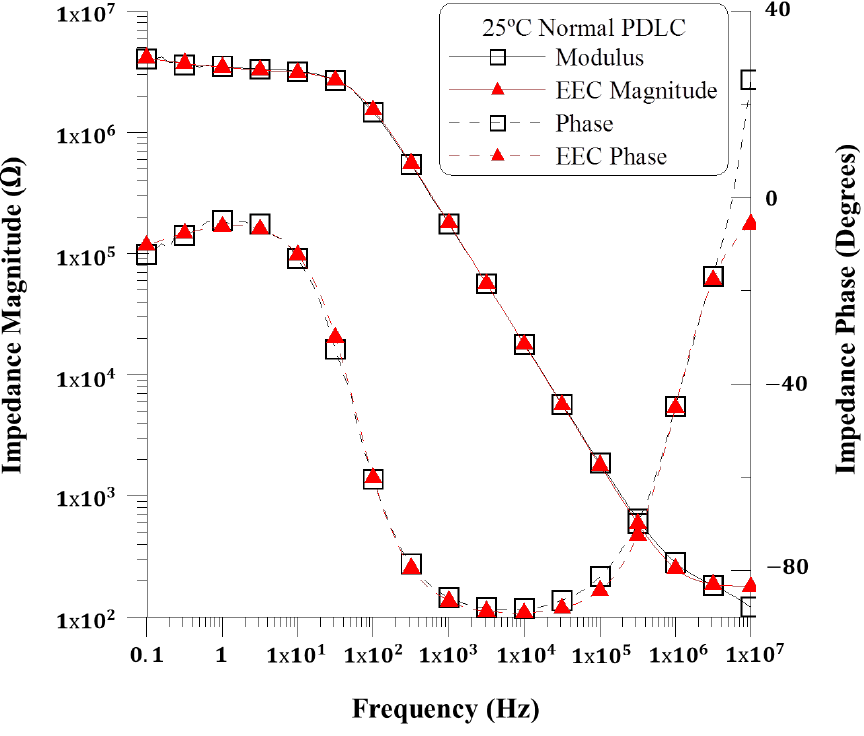
Figure 6. Experimental modulus and phase (squares-line) and simulated data (triangles-dashed line) for a frequency range from 10 −1 Hz to 10 7 Hz in the PDLCs